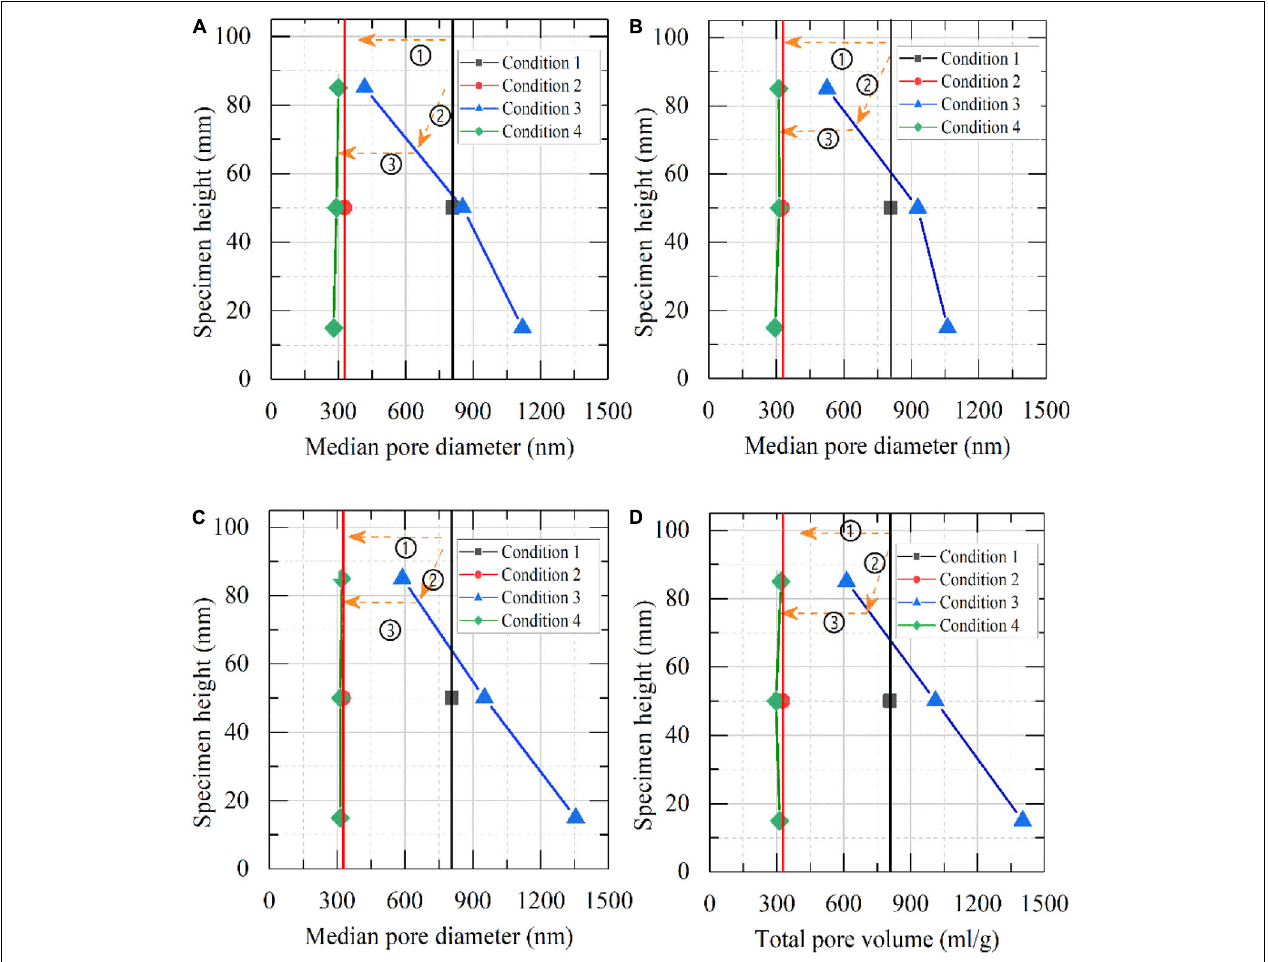
FIGURE 9 | Variation of median pore size for soil samples with condition: (A) undisturbed, (B) after compressing, (C) after freezing-thawing, (D) after freezing-thawing and compressing. (cid:192) Consolidation test, (cid:193) freeze-thaw test, and (cid:194) consolidation